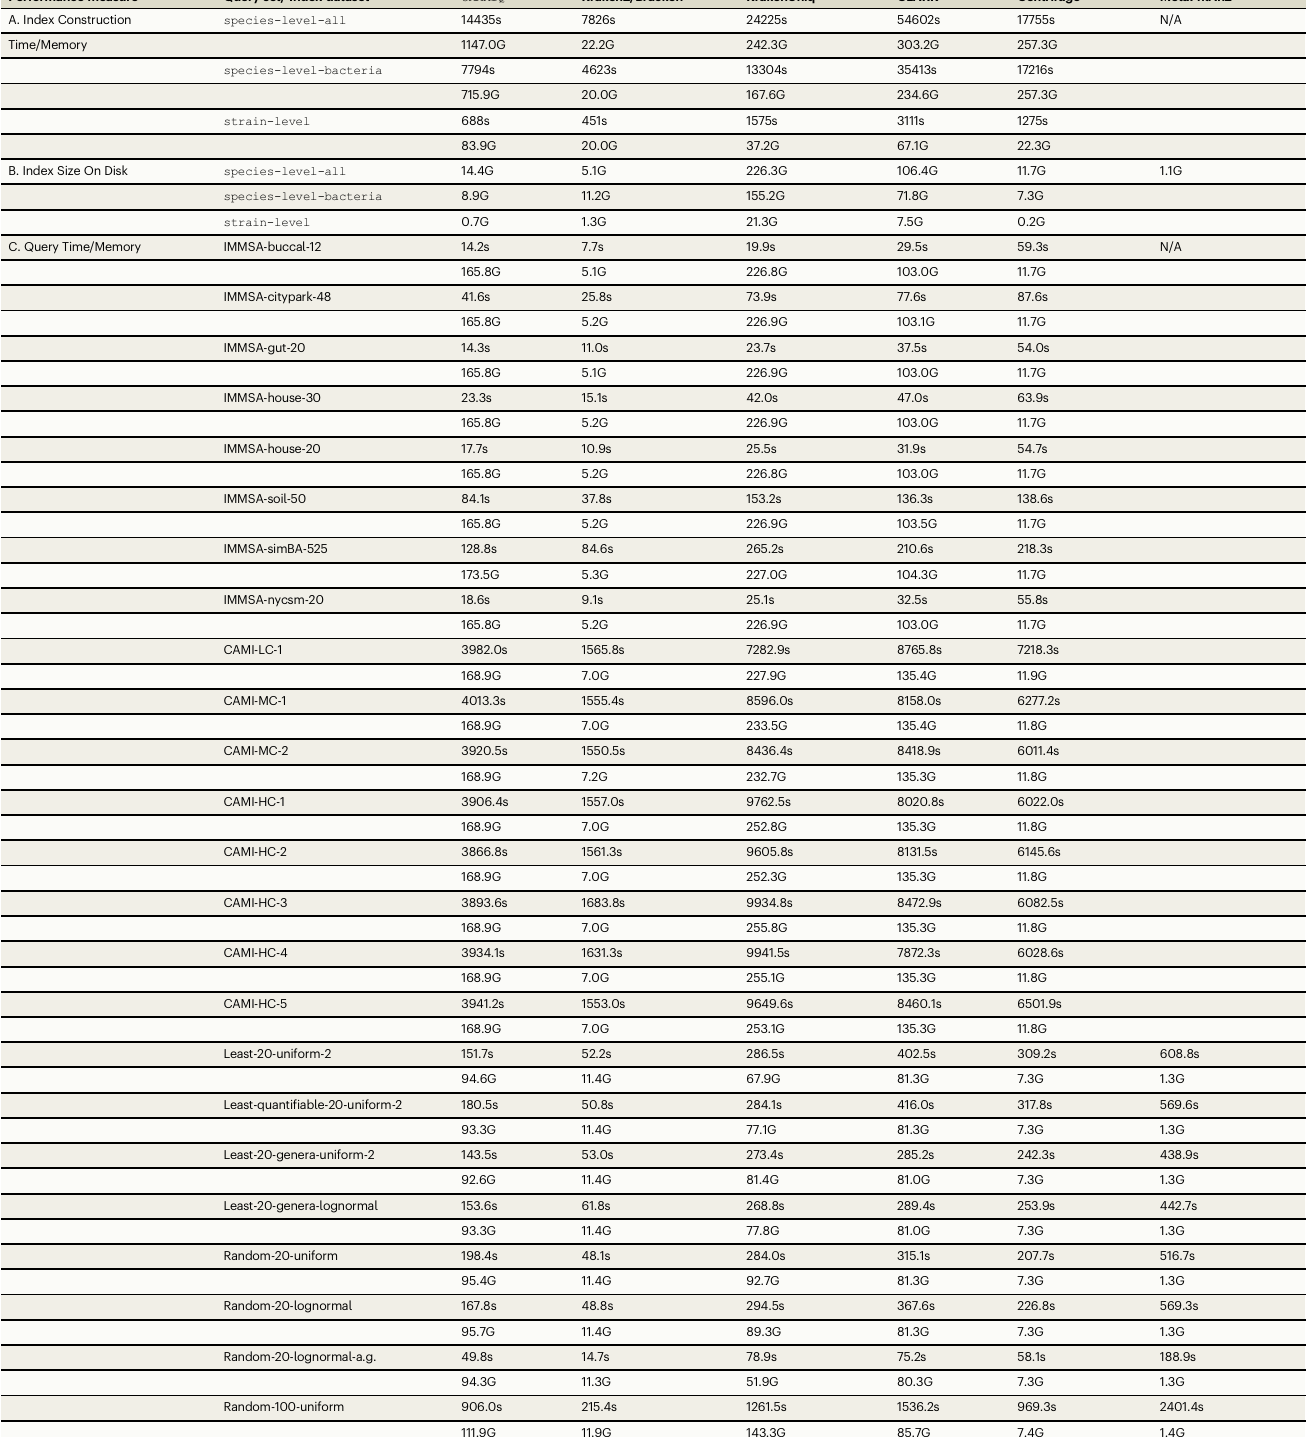
Indexconstructiontime/memory:timeandpeakRAMusagerequiredbyeachtooltobuildtheindexuponthe species-level-all , species-level-bacteria and strain-level indexdataset, with32threads,withanexceptionthatCLARKonlysupportsasinglethreadtobuilttheindex;MetaPhlAn2usedacollectionofpre-builtmarkergenes,whichmayrequireseveraldaystocomplete; forKraken2weincludedthetimetopreprocesstheinputgenomes(fasta fi les).Indexsizeondisk:thetotalindexsizeondiskforthethreeindexdatasetsrequiredbyeachsoftwaretool.Querytime/ memory: timeandpeak RAM usageto assign allreadsineach query setto one (or two) genome(s) when running with a singlethread;for CAMMiQ we included the required ILP running time and memoryusagefor A 2 typequeryonCAMIandIMMSAbenchmarkquerysetsand A 3 typequeryon species-level-bacteria querysets;foralltoolsexceptMetaPhlAn2,timetoloadtheindexinto mainmemorywereexcluded;forMetaPhlAn2wemeasuredthetotalalignmenttime.NotethatBrackenindexconstructionandquerieswillpost-processKraken2output,sowegroupthemtogether. Forall memory measurements1G=2 30